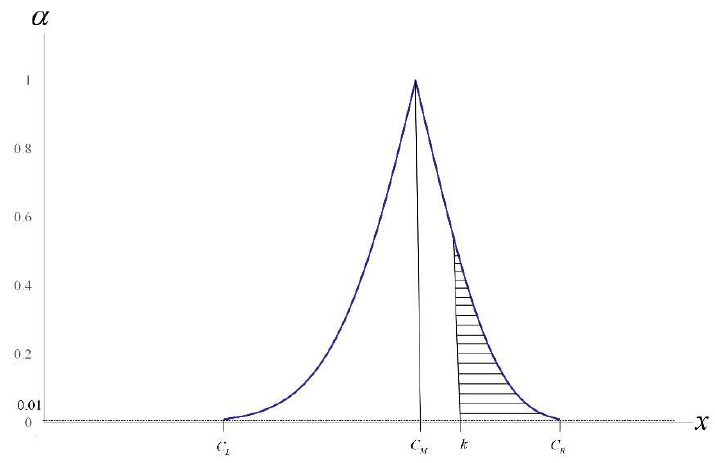
Figure 1. Membership functions of η ( x ) with vertical line x = k